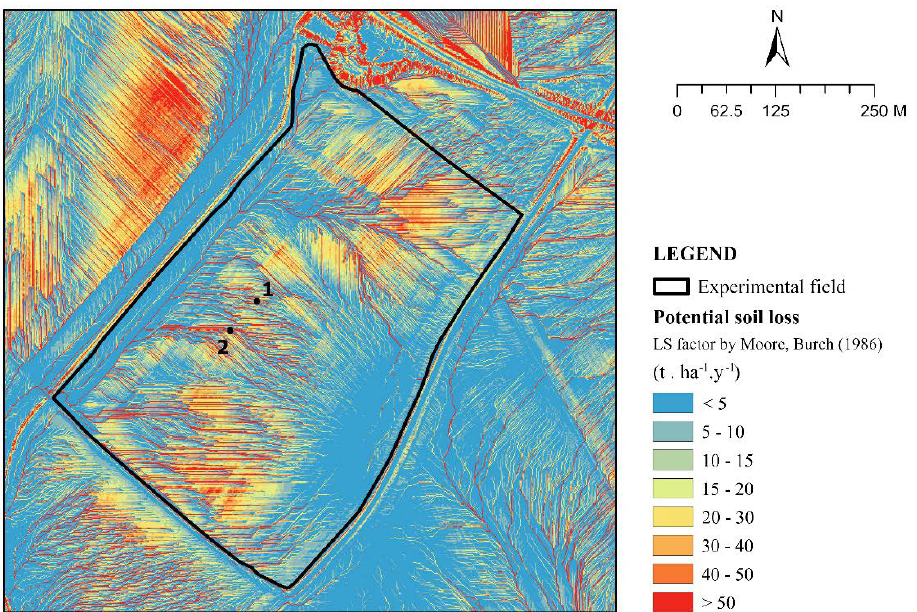
Figure 7. Potential yearly soil loss, determined by USLE equation.